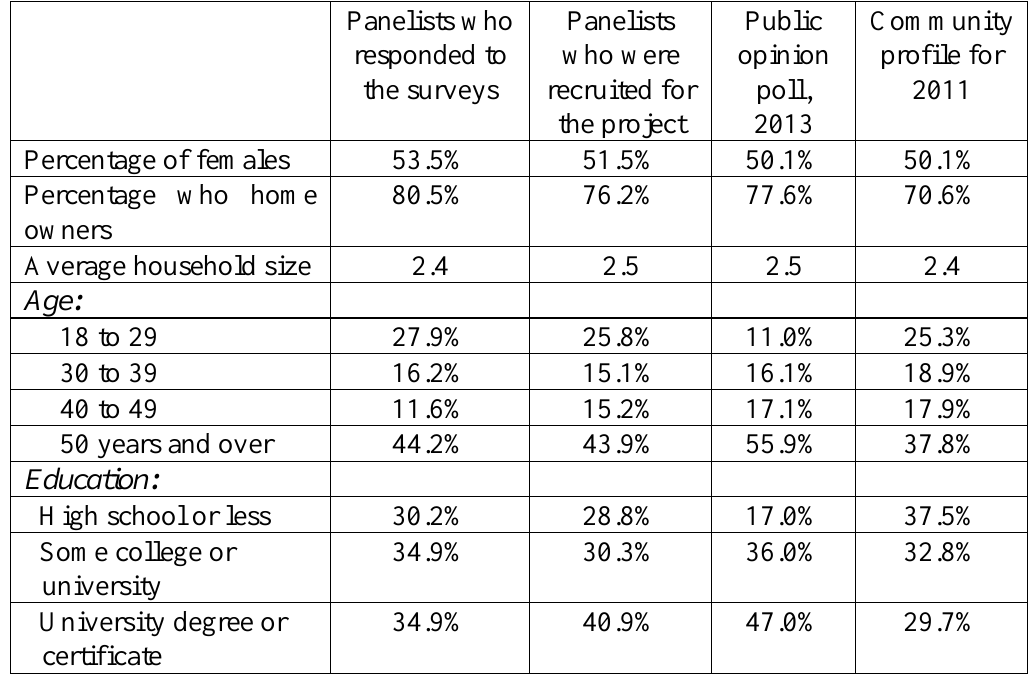
Table 2: Demographic Comparison between Panelists and Public Opinion